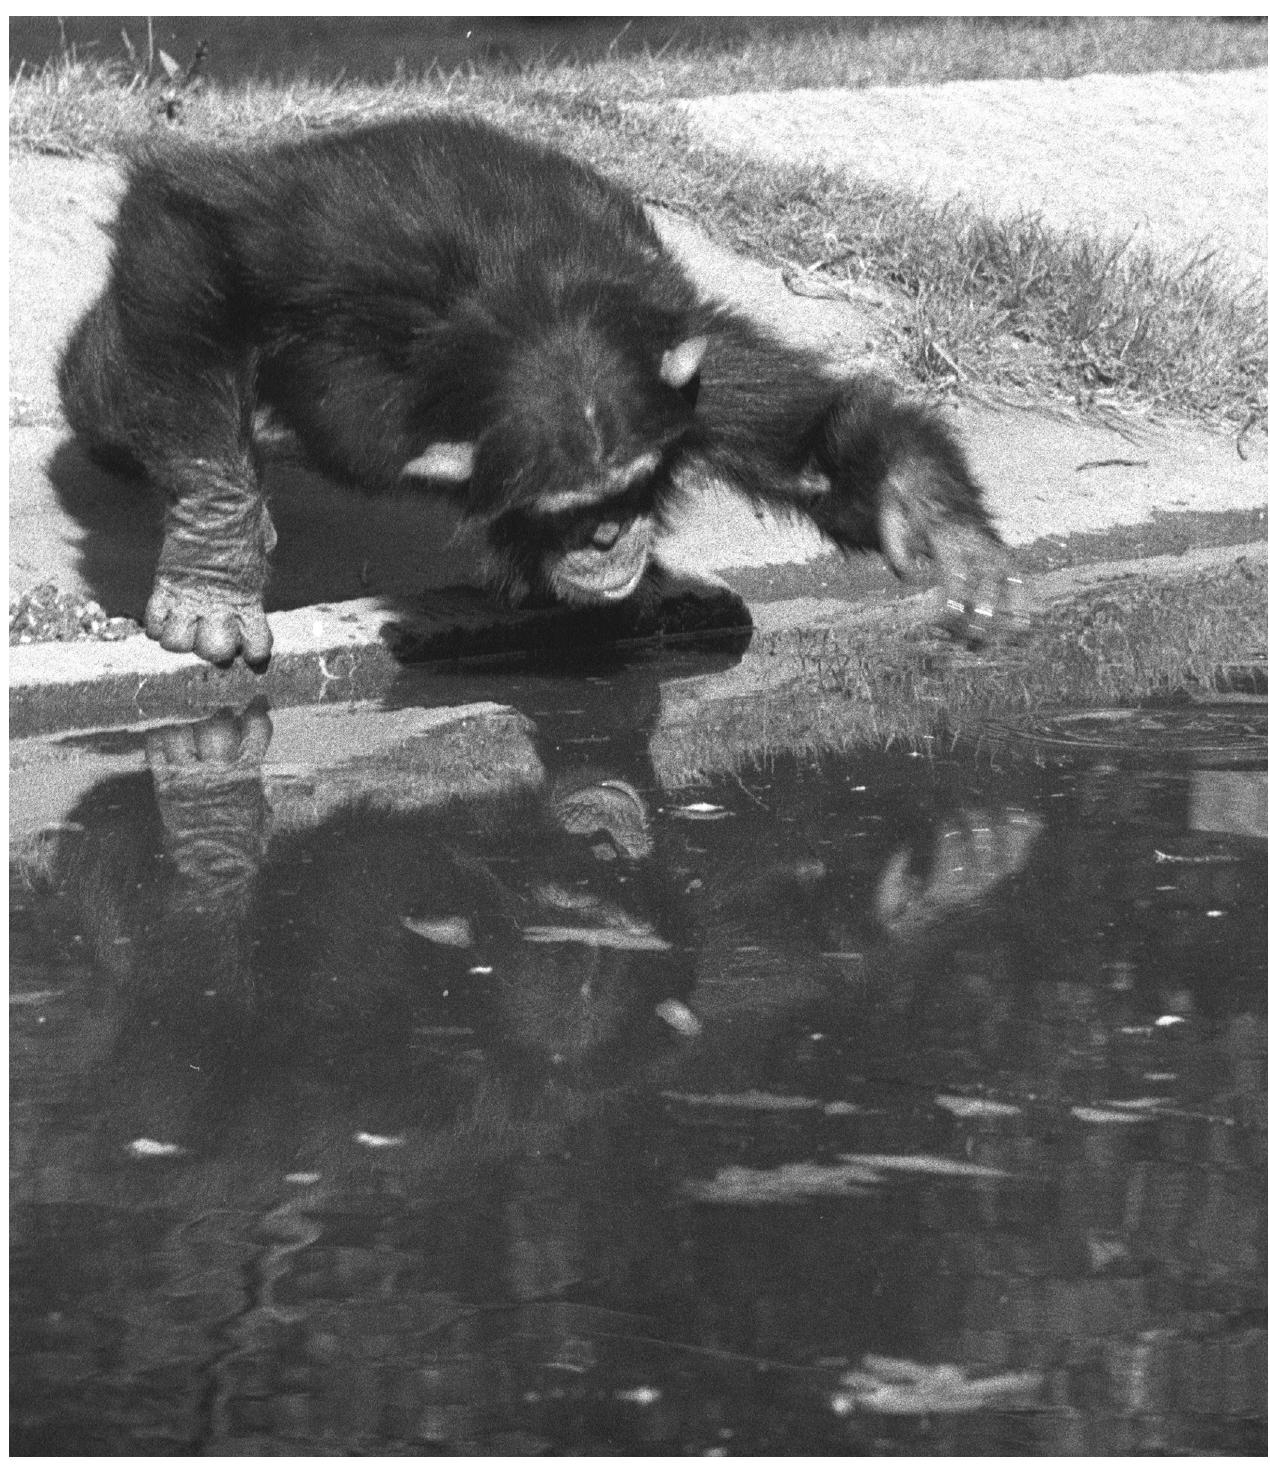
Fig 1. Chimpanzees spontaneously explore their mirror reflection by pulling strange faces or inspecting parts of their bodies that they cannot see otherwise. Here, a young male at a zoo stares at his own reflection in a water moat, occasionally disturbing the surface with his hand. Photograph by Frans de